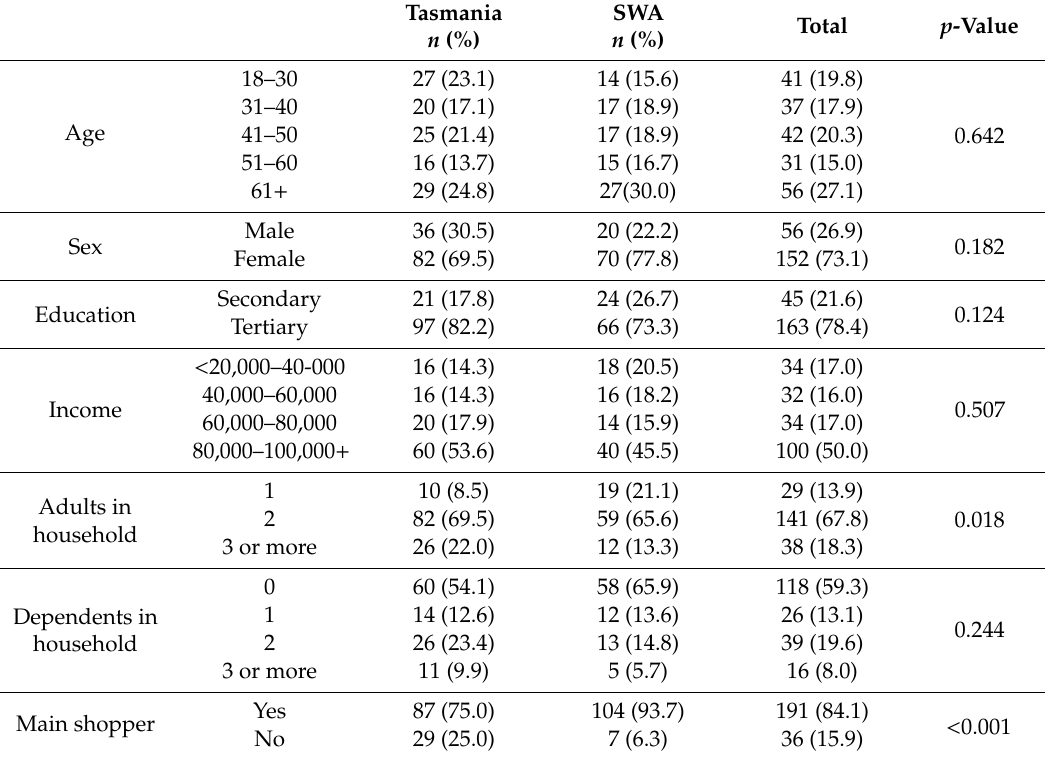
Table 1. Participant demographic characteristics in Tasmania and